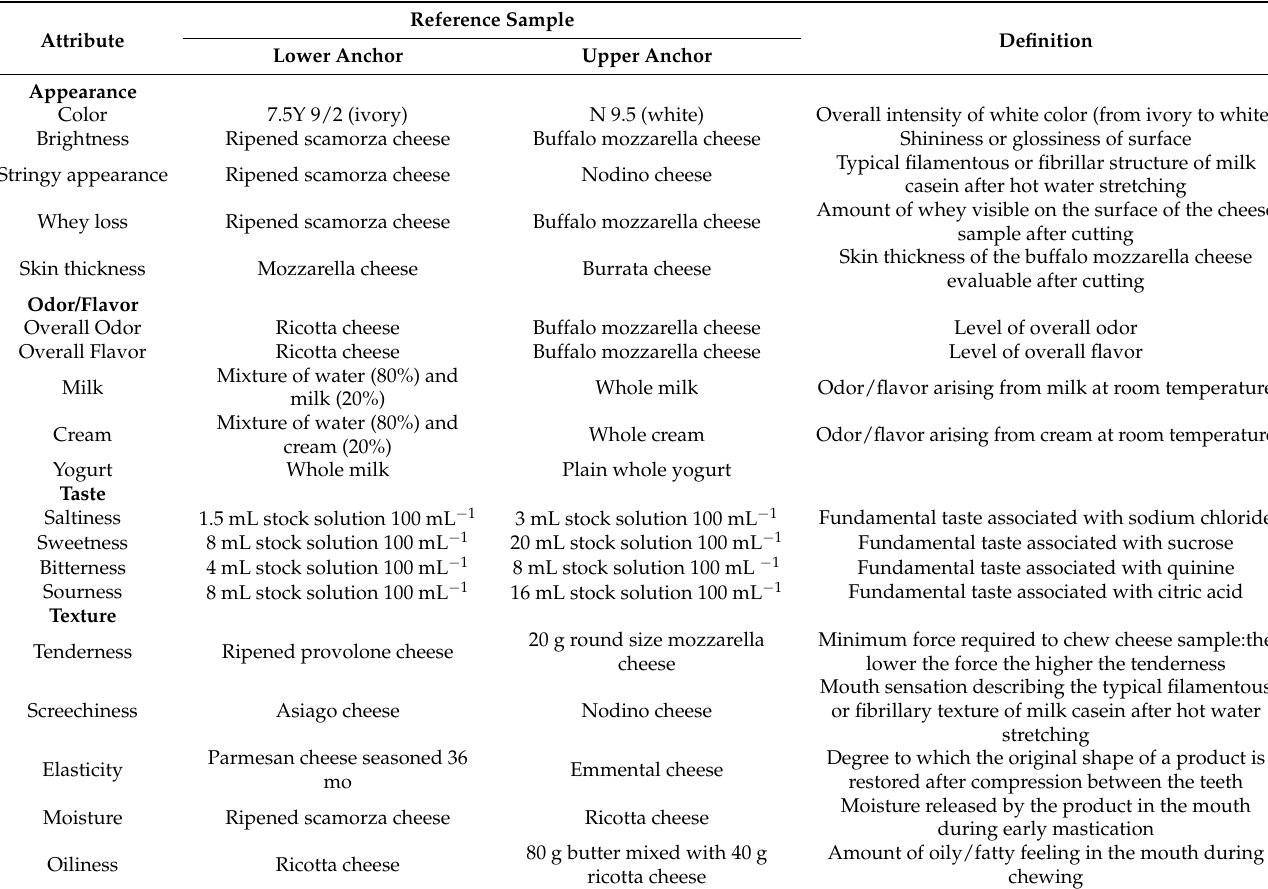
Table 2. List of attributes and reference samples used by the 10-member trained panel for Buffalo mozzarella cheese sensory profiling 1